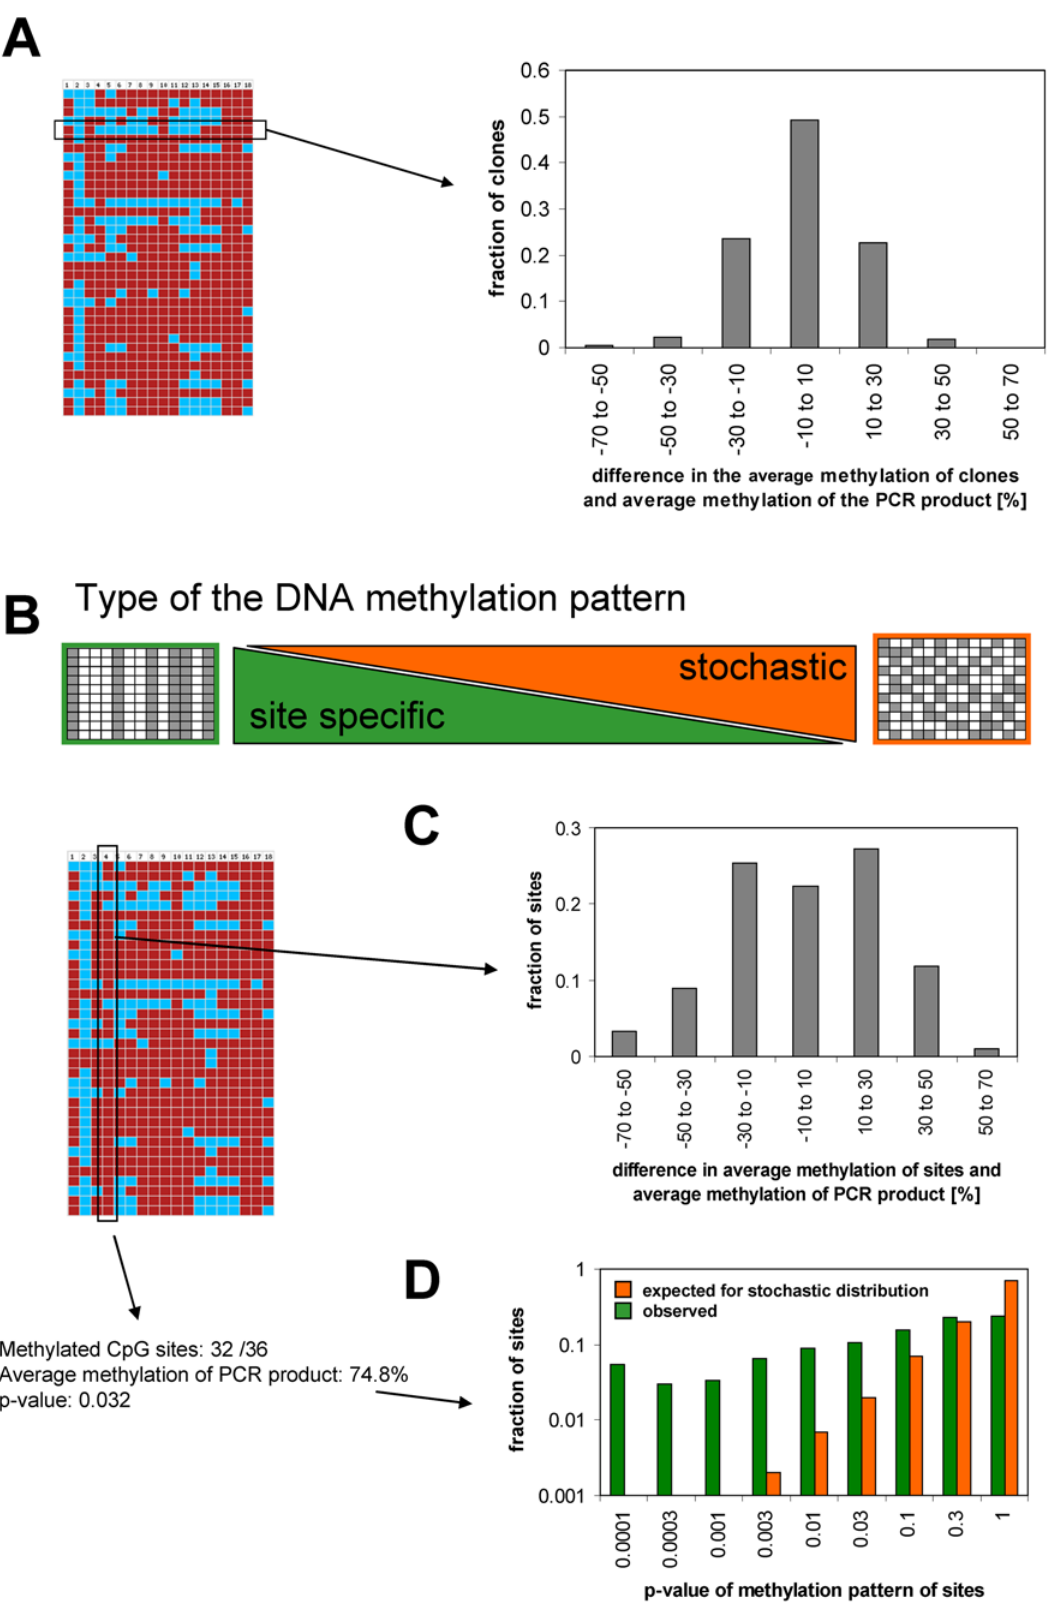
Figure 2. Analysis of DNA methylation patterns of amplicons. (A) Average methylation levels of clones were extracted and compared with the average methylation level of the corresponding PCR product. (B) Extreme types of possible patterns of DNA methylation being either distributed in a site-specific manner or stochastically. (C) Average methylation levels of all CpG sites from all PCR products were compared with the average